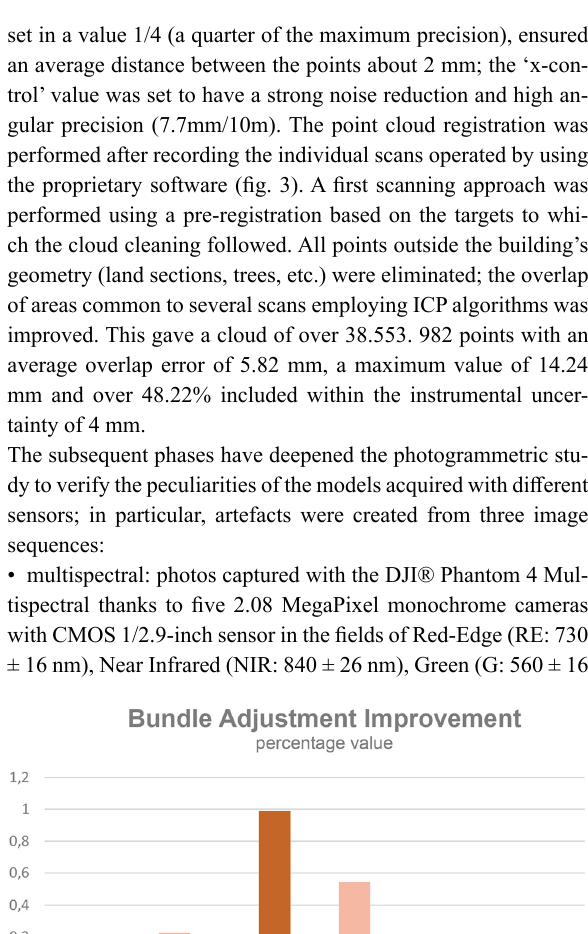
Figure 3. 3D laser scanning: point cloud model and data